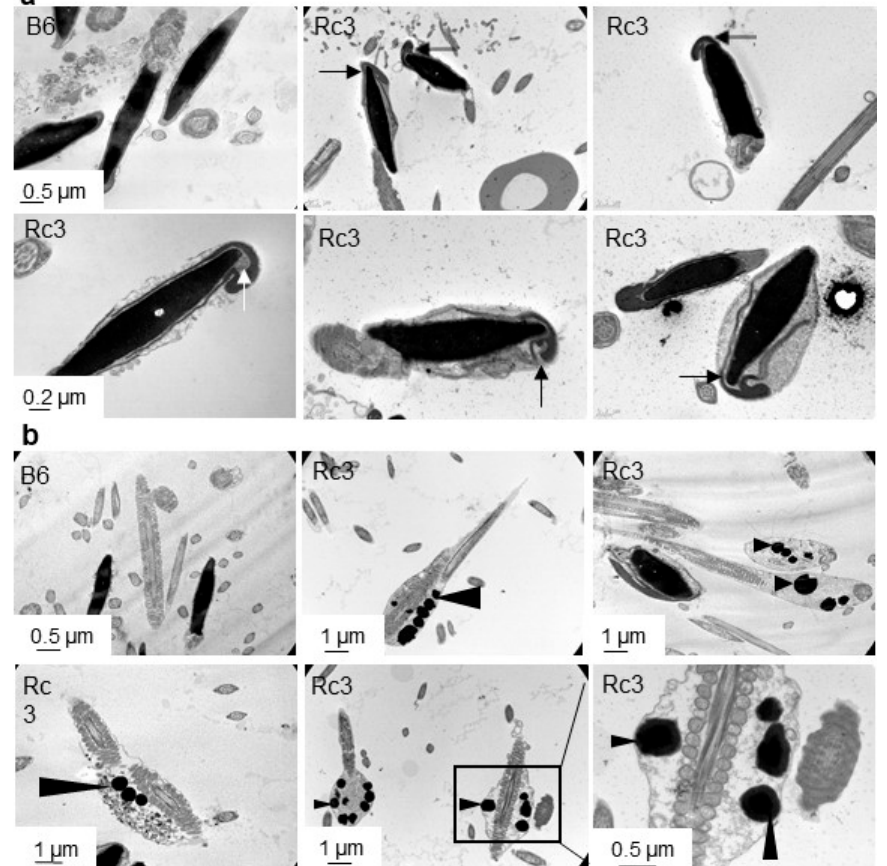
Figure 6. Observation of B6 and Rc3 sperm heads ( a ) and flagella ( b ) using electron microscopy. No abnormality was observed on B6 sperm where nuclear and inner acrosomal membranes seem joined, whereas the acrosome seems abnormally attached to the nucleus in approximately 50% of the sperm head of Rc3 males ( a , arrows), in addition to the presence of lipid droplets ( b , arrowheads) in the residual bodies at the level of the midpiece in approximately 15% of the sperm.